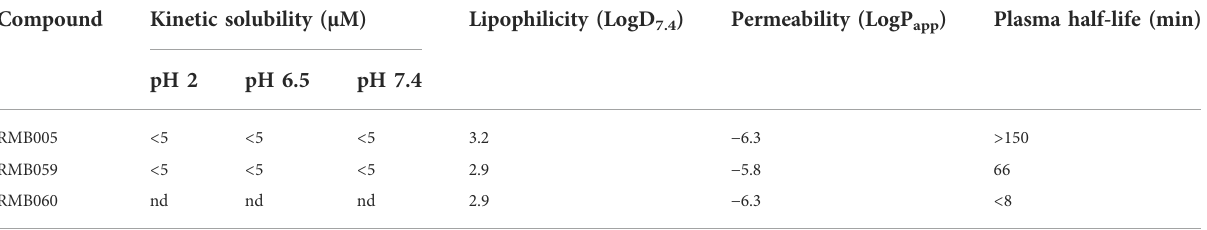
TABLE 2 Predicted solubilities, lipophilicities and permeabilities in vitro . Compound